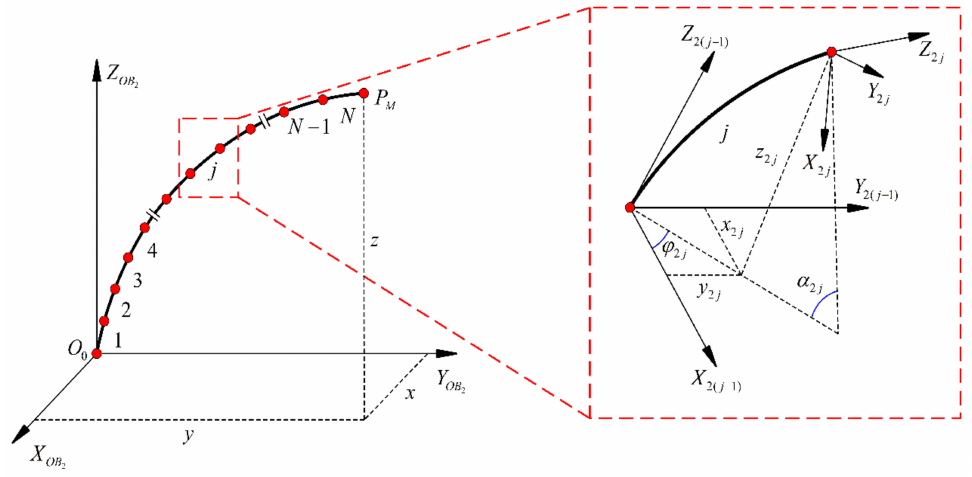
Figure 3. Schematic diagram of the